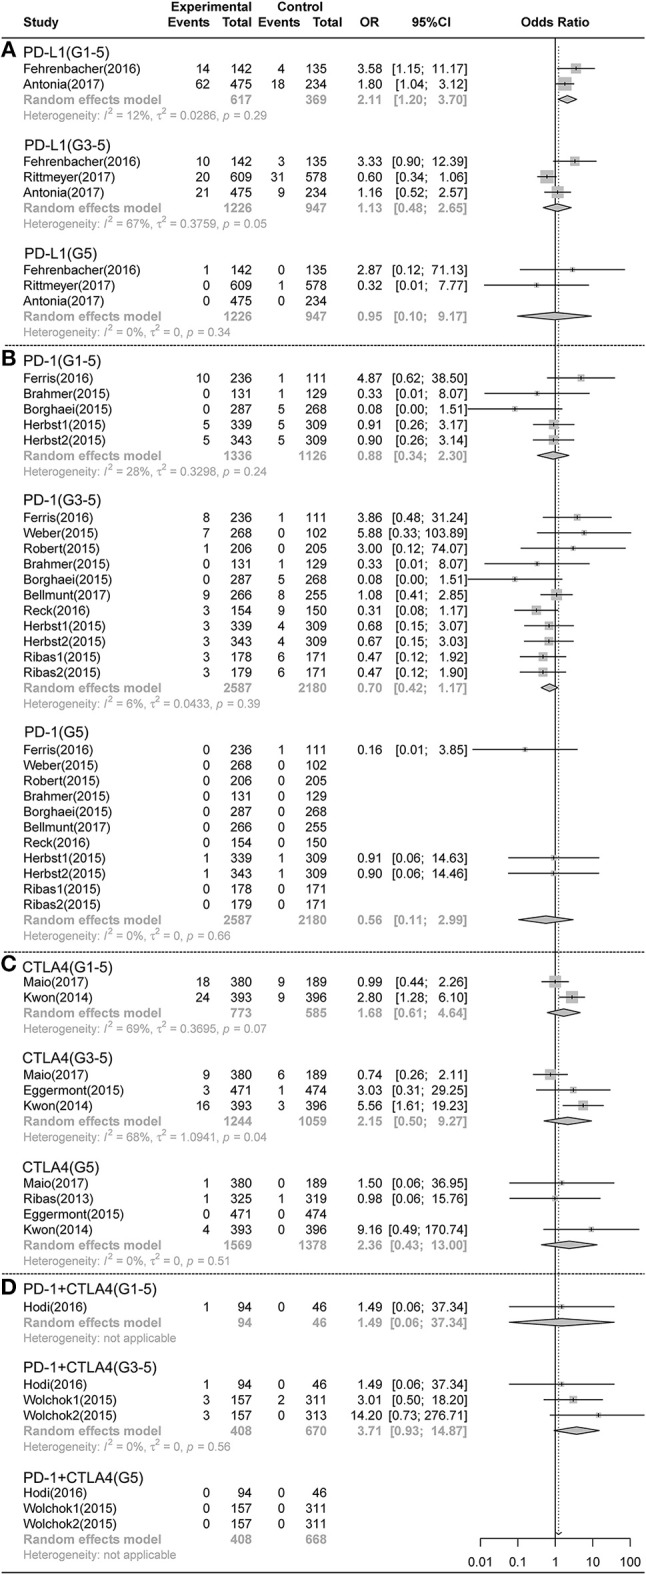
Forest plot analysis of pneumonia comparing PD-1/PD-L1/CTLA4 with control therapies. (A) PD-L1 inhibitor V.S. chemotherapy/placebo; (B) PD-1 inhibitor V.S. chemotherapy; (C) CTLA4 inhibitor V.S. chemotherapy/placebo; (D) PD-1 combined CTLA4 V.S. ICI. G1-5, grade 1-5; G3-5, grade 3-5, G5, death.